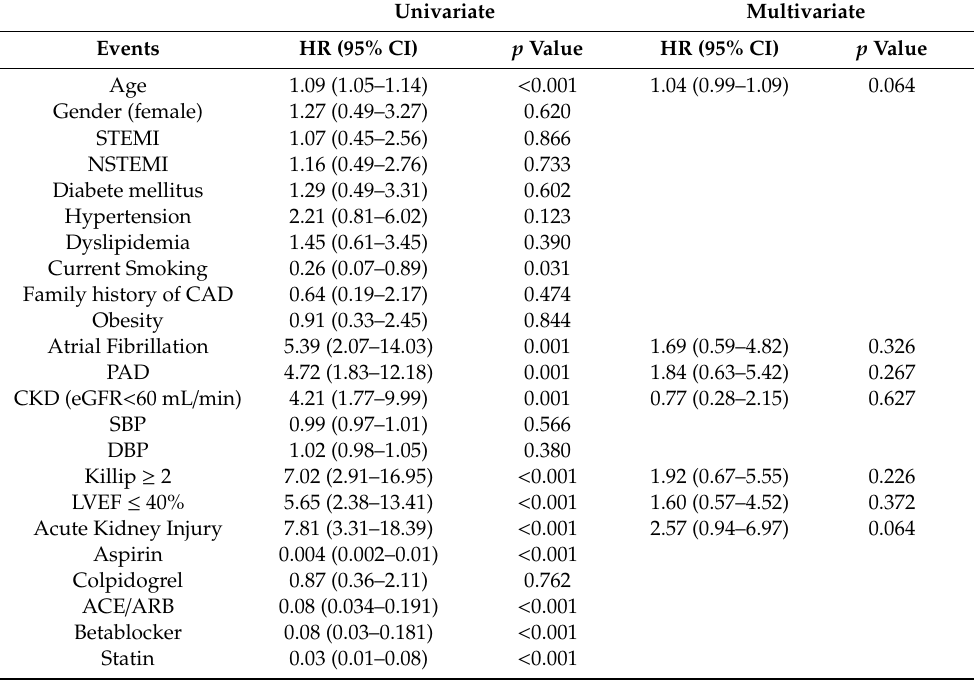
Table 7. Univariate and multivariate analysis of risk factors associated with cardiac death. Univariate